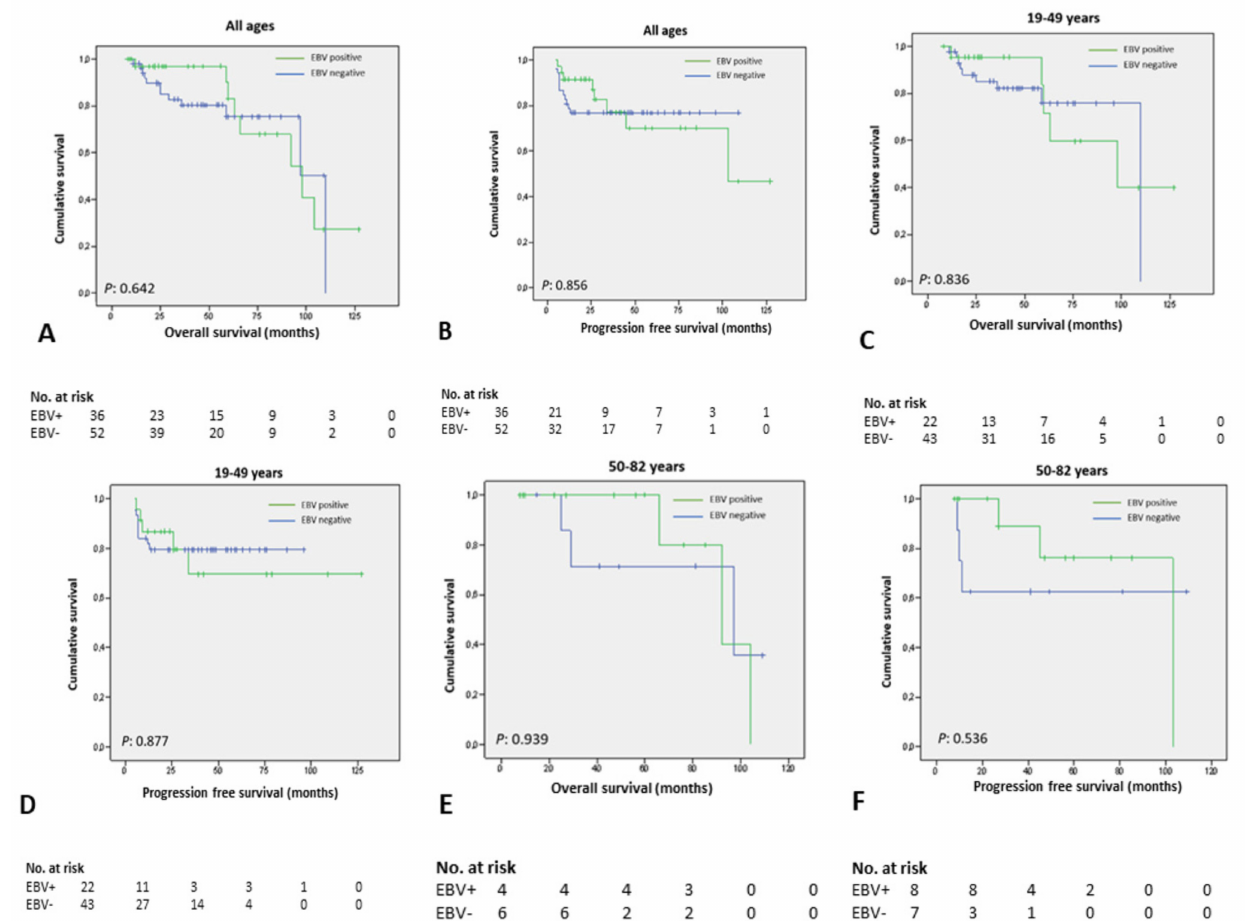
Figure 2. Survival impact of EBV adjusted for age-stratified subgroups. ( A , B ) Overall survival and progression-free survival for all ages; ( C , D ) Overall survival and progression-free survival for patients between 19 and 49 years old; ( E , F ) Overall survival and progression-free survival for patients above 50 years